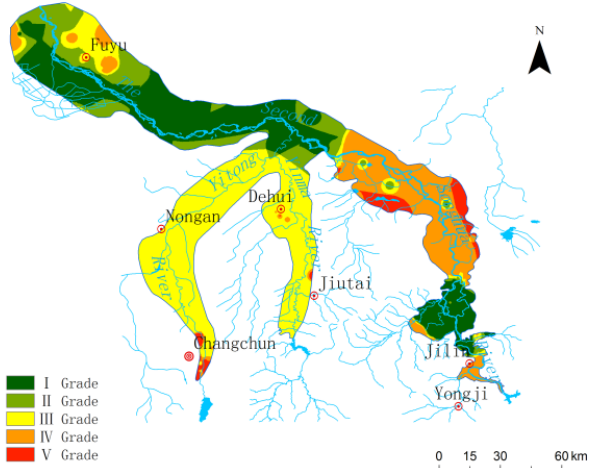
Figure 9. Distribution of water quantity suitability.